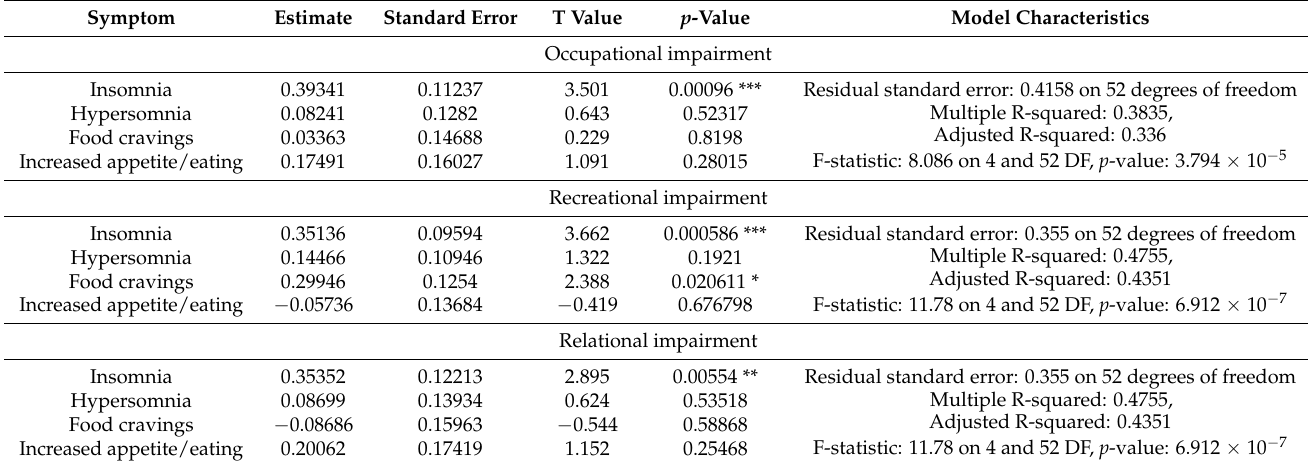
Table 3. Relationships between premenstrual functionality and behavioral symptoms.